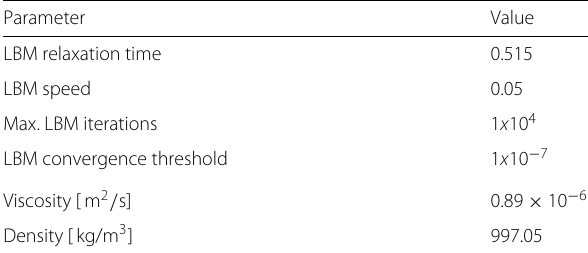
Table 2 D2Q9 LBM simulation